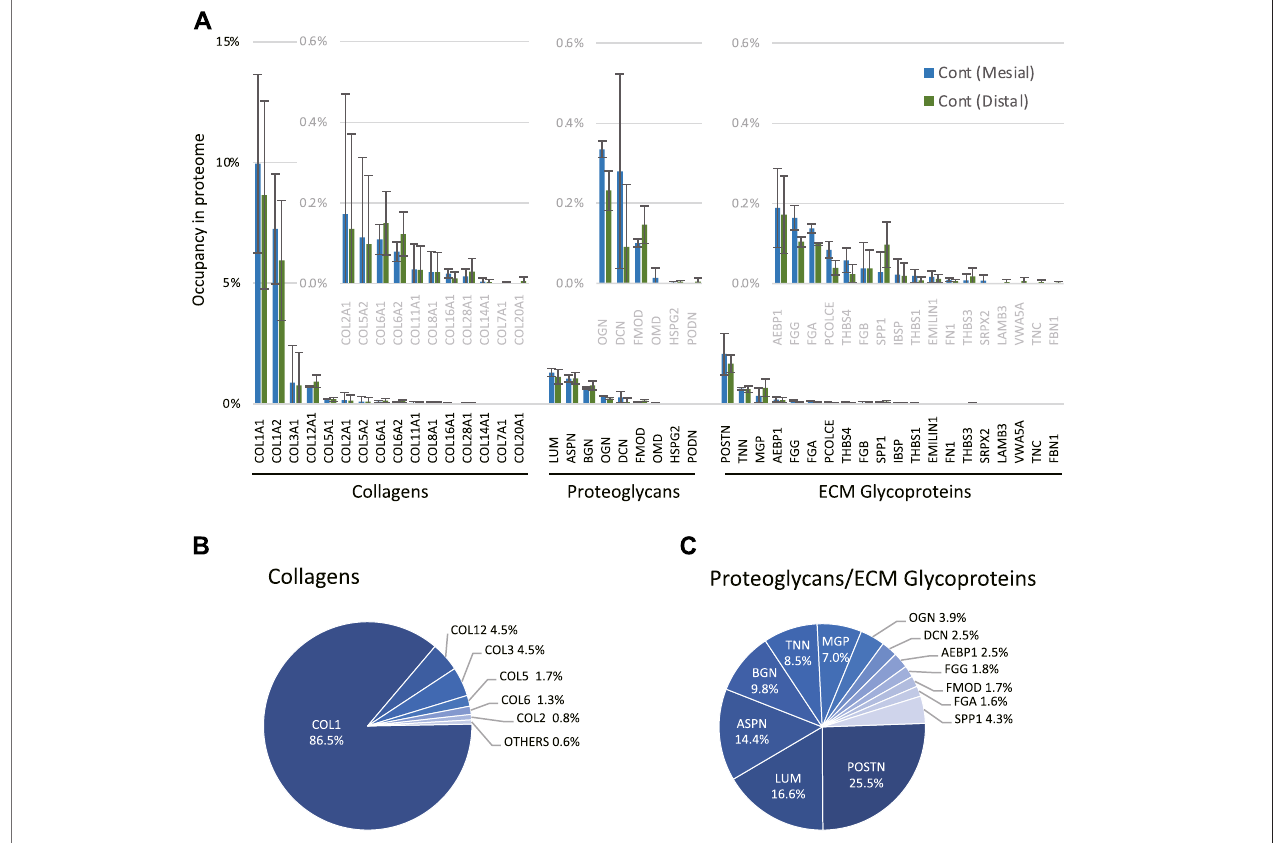
FIGURE 3 | Pro fi le of core matrisome proteins in the mouse molar PDL. (A) Pro fi le of core matrisome (collagens, proteoglycans, and ECM glycoproteins) in the mousemolarPDLincontrols.Insetsaremagni fi edgraphsofthecorrespondingregions( n =3,mean±SD) (B) Pro fi leofcollagensinthemousemolarPDLincontrols. (C) Pro fi le of proteoglycans and ECM glycoproteins in the mouse molar PDL in controls.